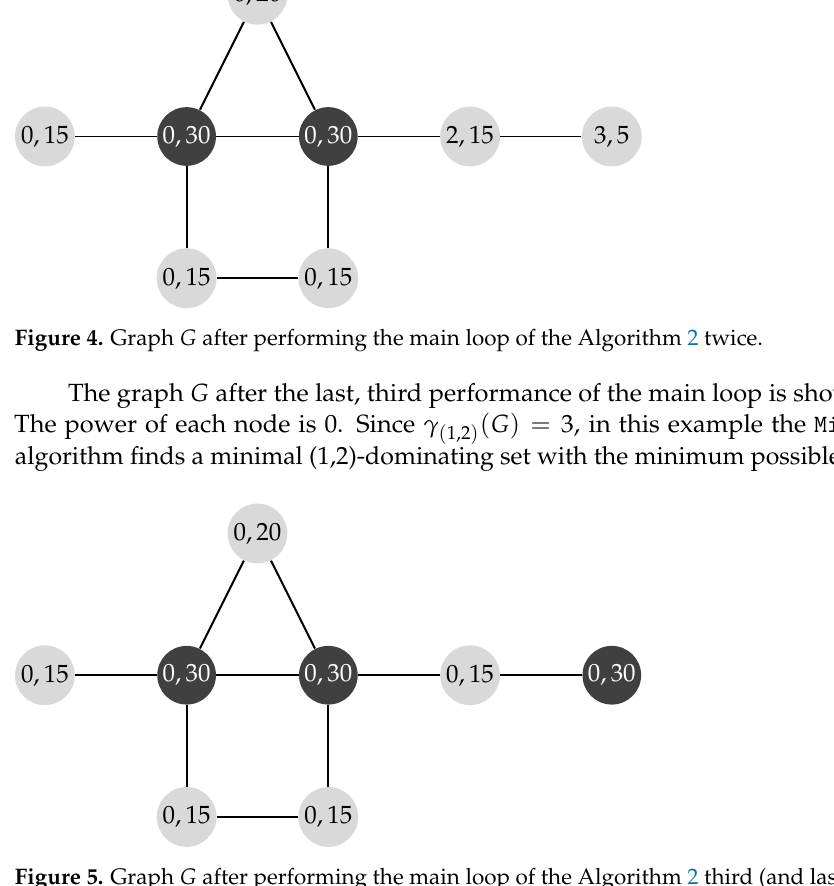
Figure 5. Graph G after performing the main loop of the Algorithm 2 third (and last)